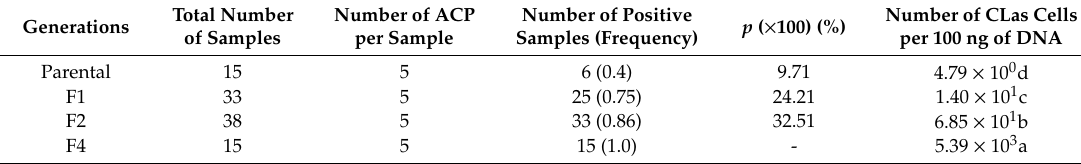
Table 1. Estimation of the proportion of CLas positive ACPs ( p ) and the number of CLas cells per 100 ng of DNA on each generation analyzed. The p parameter was calculated by the formula p = 1 − I (1 / k) , where I is the frequency of non-infected insects and k is the number of insects used per